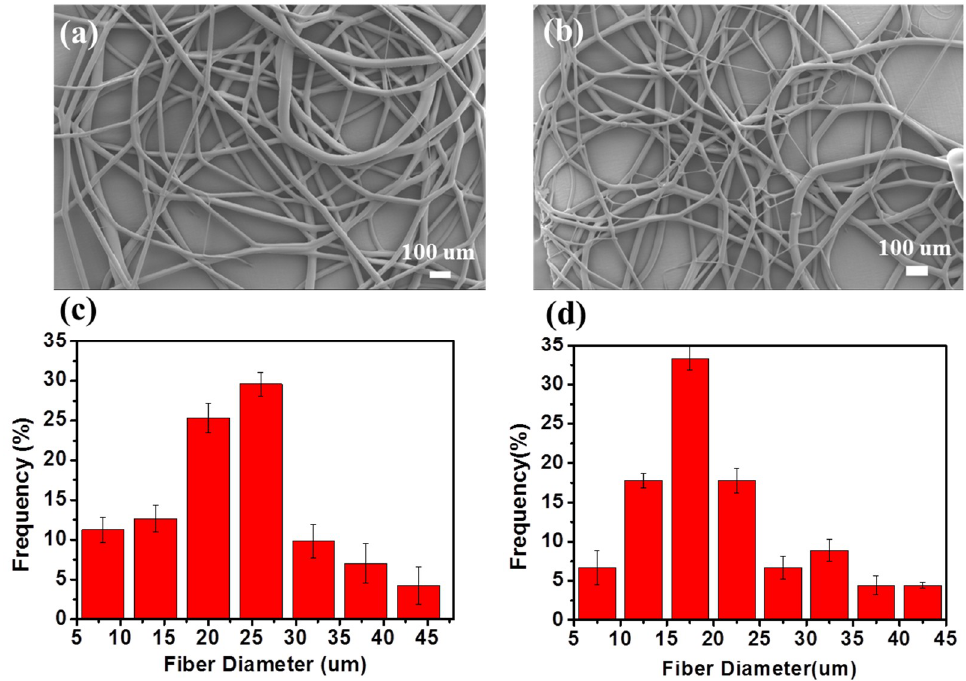
Figure 3. ( a , b ) SEM photograph and ( c , d ) diameter distribution of the melt e-spun polyurethane (TPU) fibers.